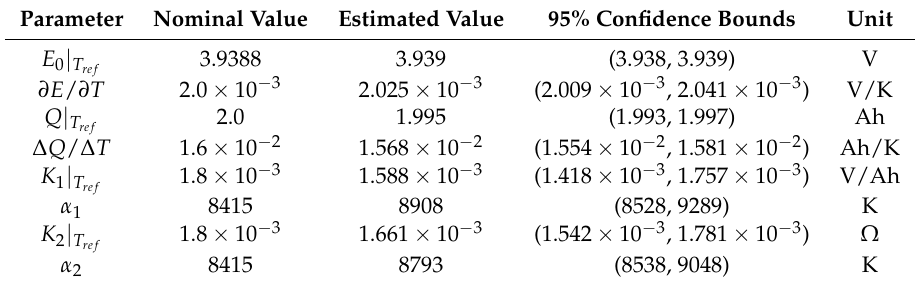
Table 7. Estimated parameters of the temperature dependency of the battery parameters during